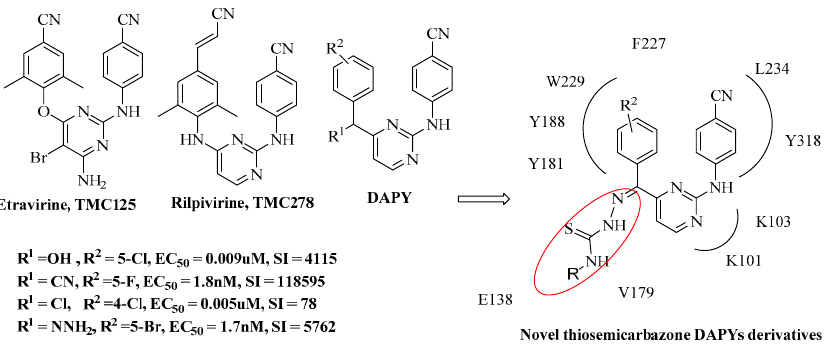
Figure 1. Designing of new DAPY-NNRTIs with the scaffold of